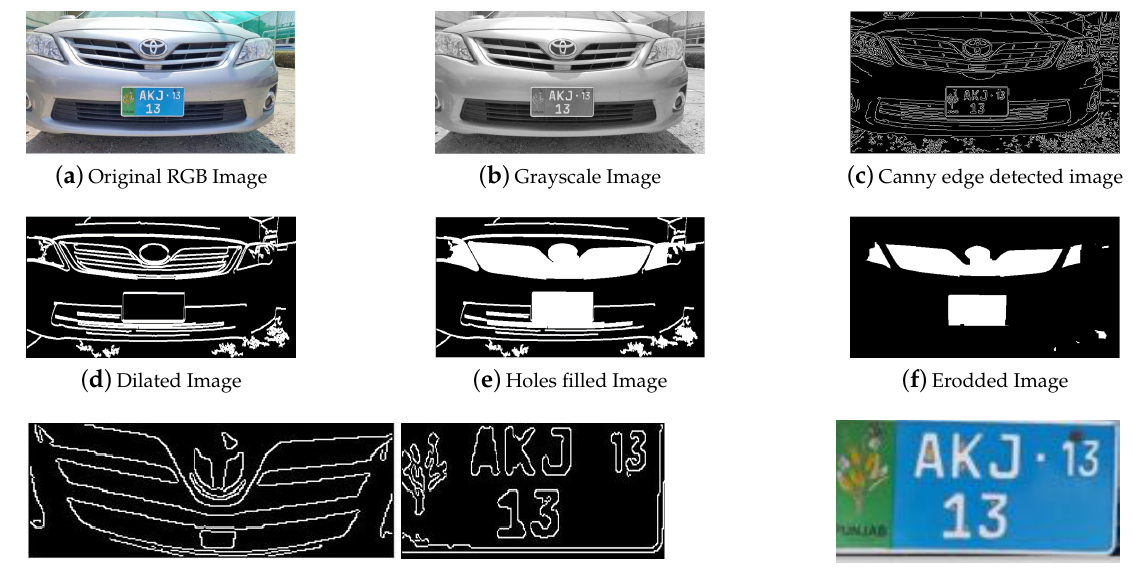
Figure 9. Results of pre-processing, edge detection, morphological operations, connected components extraction and final LP area